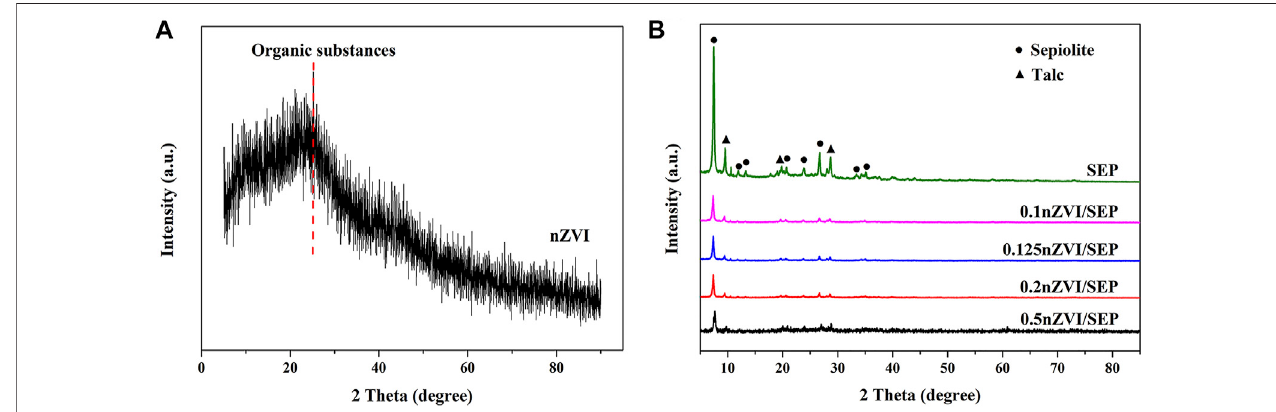
FIGURE 1 | XRD patterns of (A) nZVI, (B) SEP and nZVI/SEP composites.